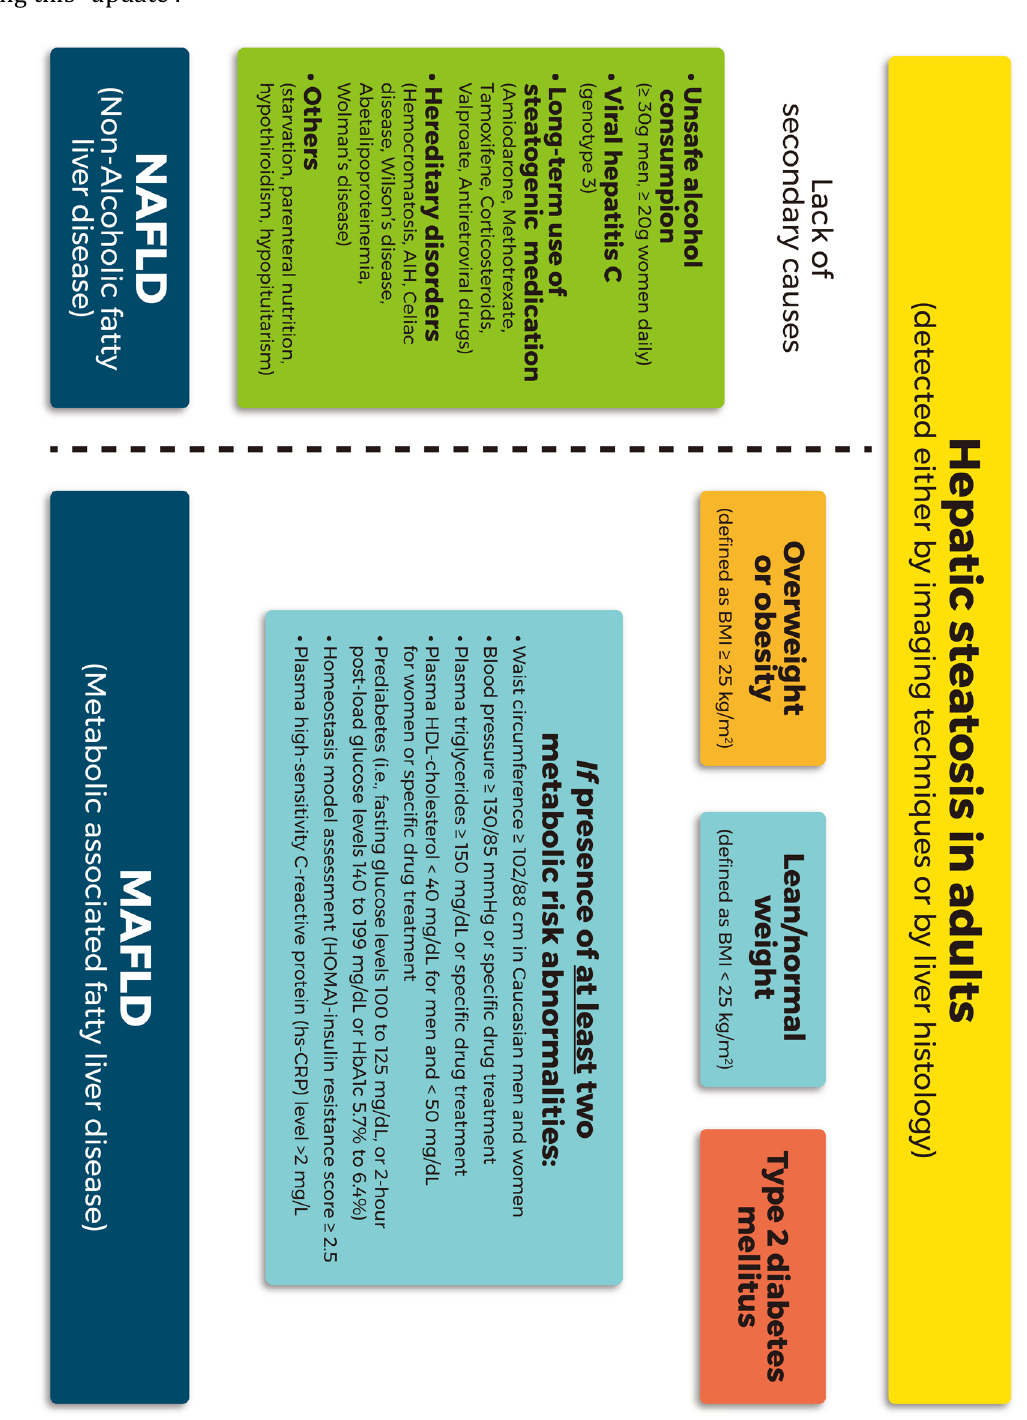
Figure 1. Comparison between the flowchart for the diagnostic criteria for NAFLD and the new proposed “positive” diagnostic criteria for MAFLD. AIH: autoimmune hepatitis; HDL: high density